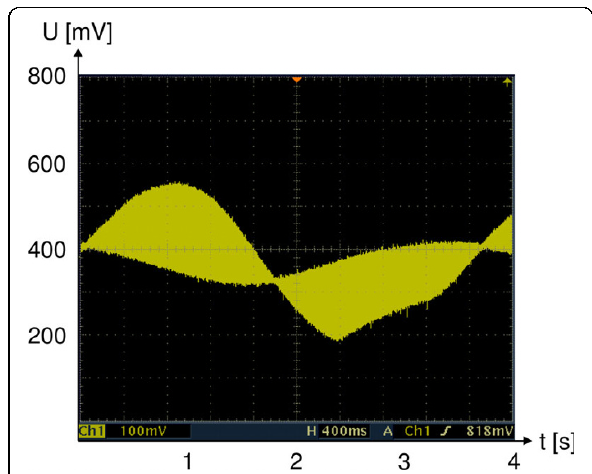
Figure 1 Diagram of millicurrent stimulation . Diagram of stimulation applied to cell-seeded collagen type-I gel samples and osteochondral explants. Electrodes of 3 mm in diameter were inserted at a distance of 3 cm. A current of 3 mA was applied; stimulation was carried out for 30 sec with a sinusiodal signal of 312 Hz amplitude modulated by two super-imposed signals of 0.28 Hz. Stimulation was repeated consecutively twice every two days for up to 3